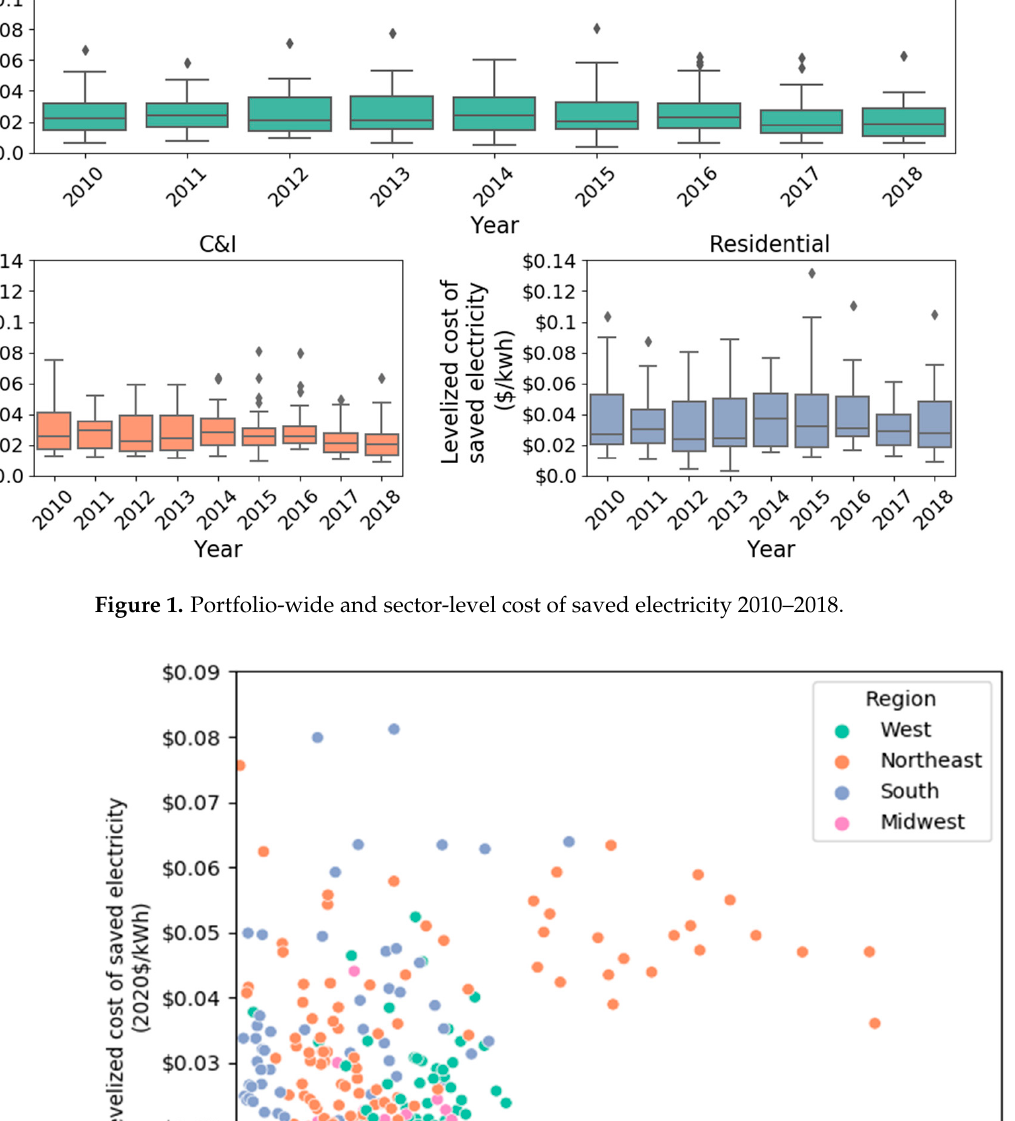
Figure 3. Cumulative savings as percent sales by state. 3.3. Regression Results We found that energy efficiency programs in our base sample display both econo- mies and diseconomies of scale, are sensitive to construction labor costs, and exhibit both year and program administrator fixed effects. Together, these factors explain 64% of the observed variation in the levelized cost of saved electricity in our dataset. We summarize these results in Table 4.